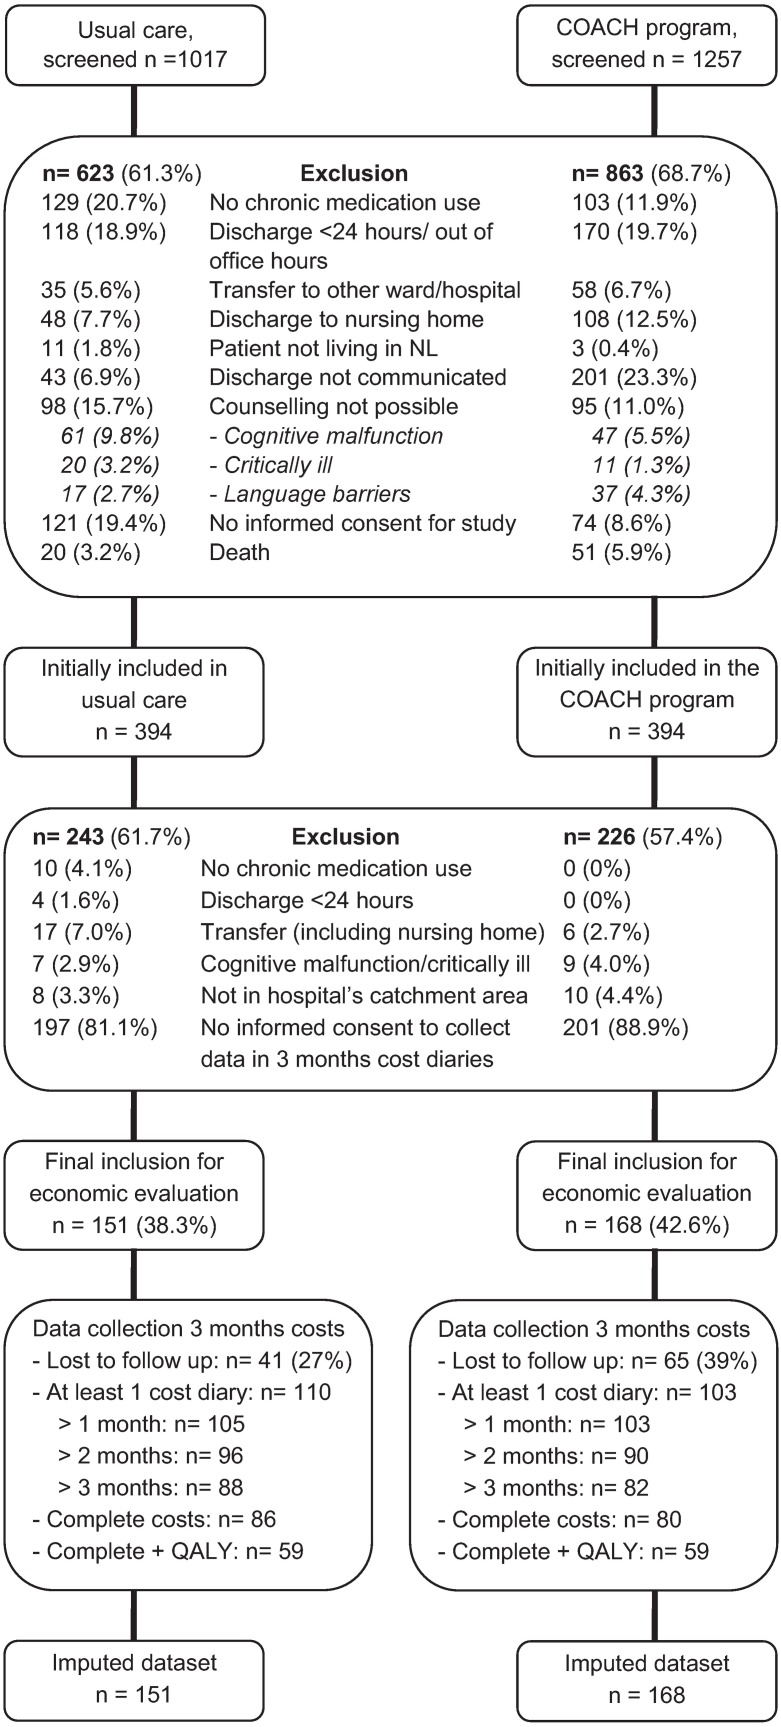
Flowchart of inclusion of patients.